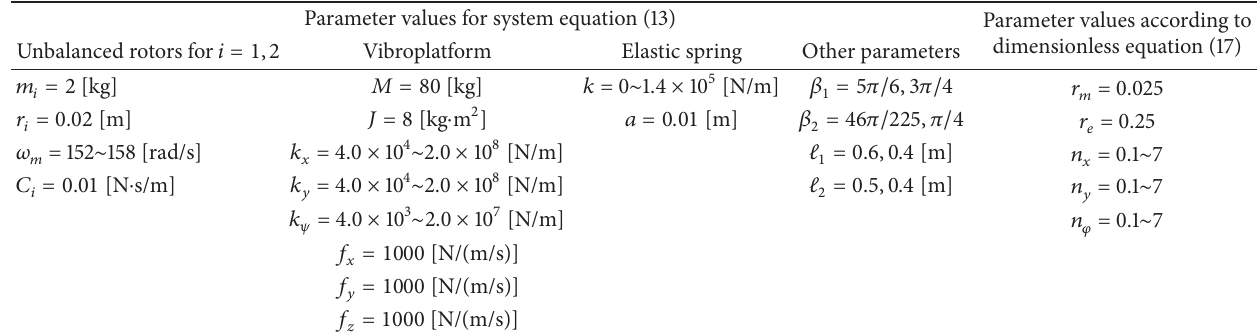
Table 1: Parameter